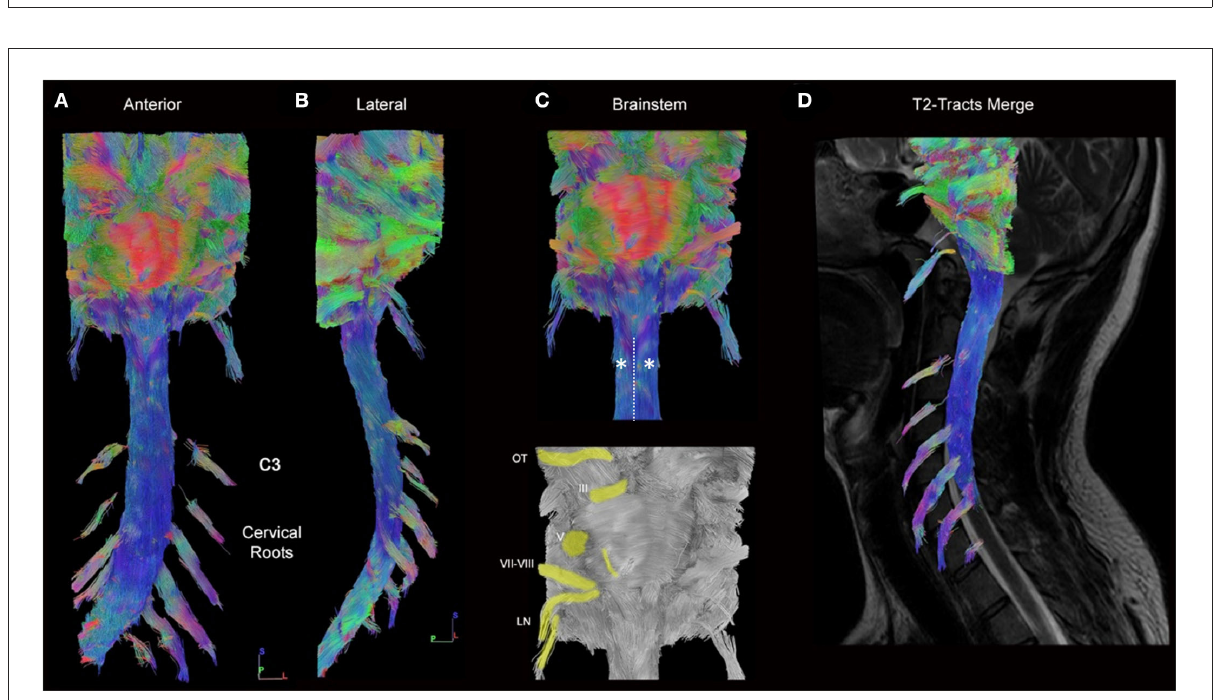
FIGURE3 Full cervical cord tractography (healthy subject). (A) Ventral and (B) lateral views of the cervical spinal cord and brainstem tractography showing the ascending/descending pathways with cervical rootlets. The emergence of the rootlets from the spinal cord can be seen laterally (turquoise). Spinal cord fibers (blue) are well reconstructed on the whole length of the spinal cord in a subject who had an important cervical lordosis. (C) From this enlargement of panel A on the brainstem, pontocerebellar fibers are seen (red), cranial nerves (from optic tracts [OT] to lower nerves [LN]), including acoustic-facial bundle [VII–VIII] are highlighted (yellow). The junction between the medulla and spinal cord was identified by its pyramidal bulging (*), and by an invagination that corresponds to the median ventral sulcus (dotted line). (D) The spinal cord tractography